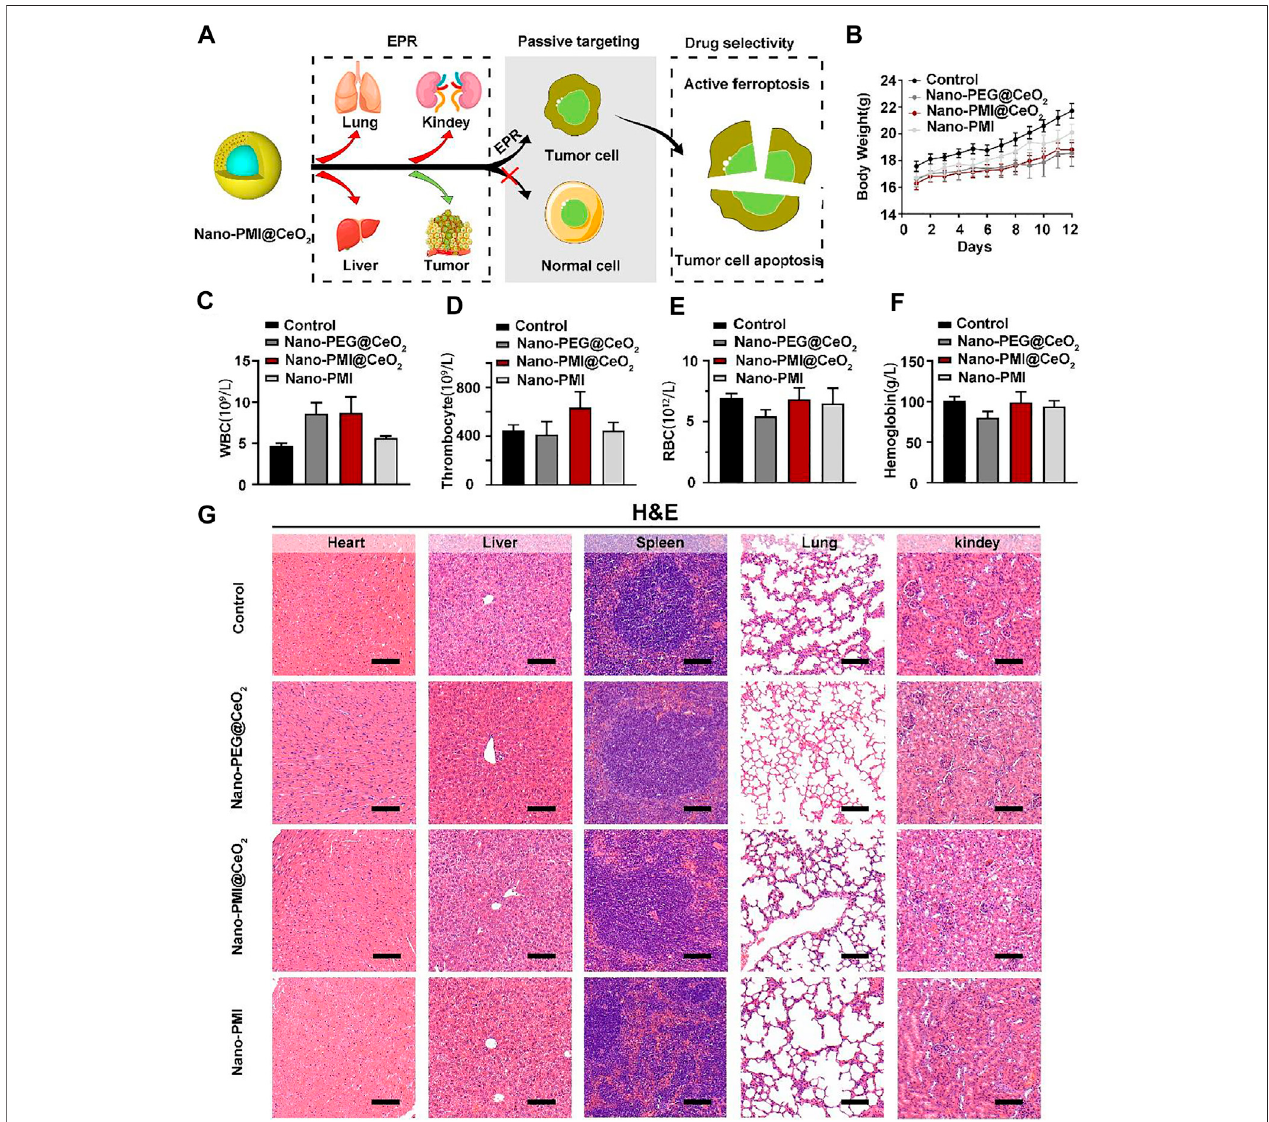
FIGURE6| Nano-PMI@CeO 2 safetyevaluation invivo . (A) Schematicillustrationoftumorspeci fi cityforNano-PMI@CeO 2 via theEPReffect. (B) Bodyweightswere measured every day to evaluate the safety of Nano-PMI@CeO 2 , Nano-PEG@CeO 2, and Nano-PMI in vivo . (C – F) Count of white blood cells (WBCs) (C) , thrombocytes (D) , redblood cells(RBCs) (E) ,and hemoglobin (F) inC57BL/6 mice withthedifferenttreatments. (G) Representativehistological H&Estainingimages ofthe heart,liver, spleen, lung, and kidney in mice with the indicated treatment. (scale bar: 100 μ m).